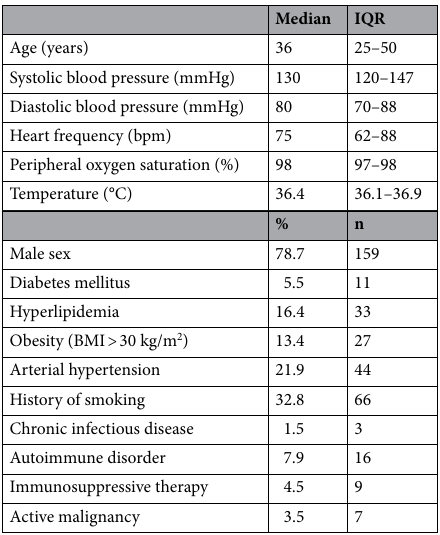
Table 1. Baseline characteristics and